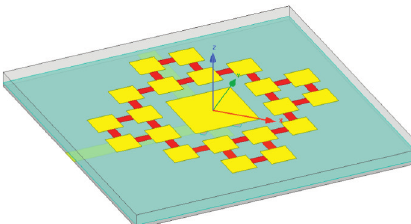
Figure 2: Configuration of the proposed RPA